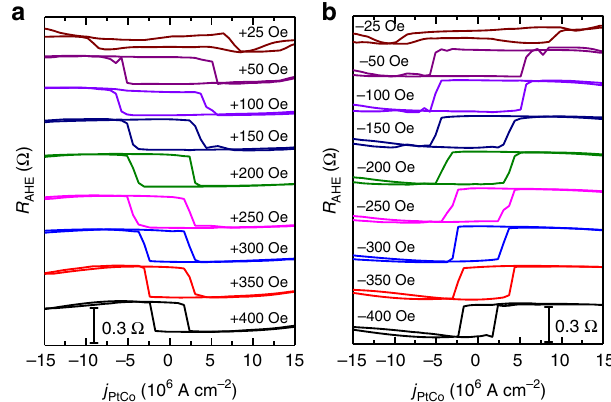
Fig. 5 CIMS measurements. R AHE as a function of j PtCo passing